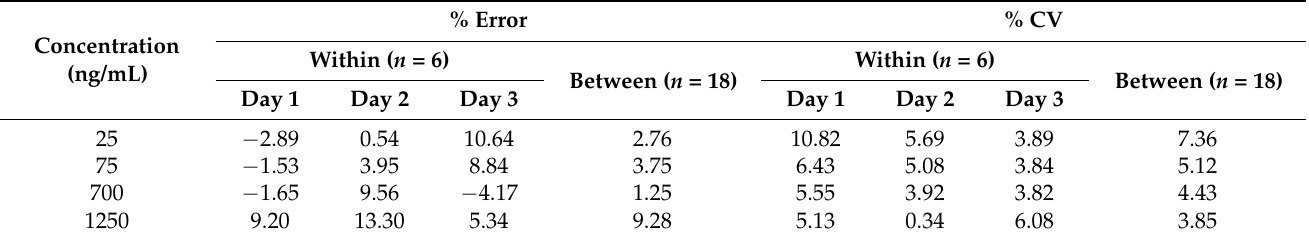
Table 2. Results of glipizide accuracy and precision in spike plasma.